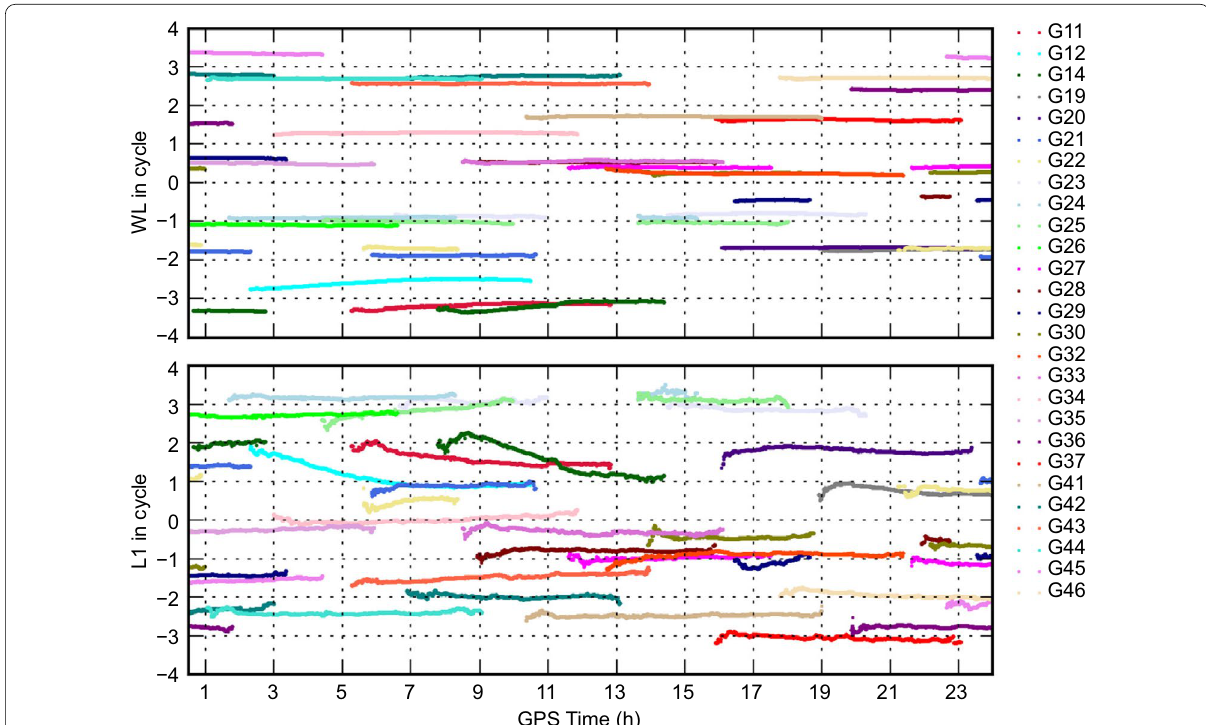
Fig. 3 Time series of hardware WL (top) and L1 biases (bottom) for BeiDou MEO